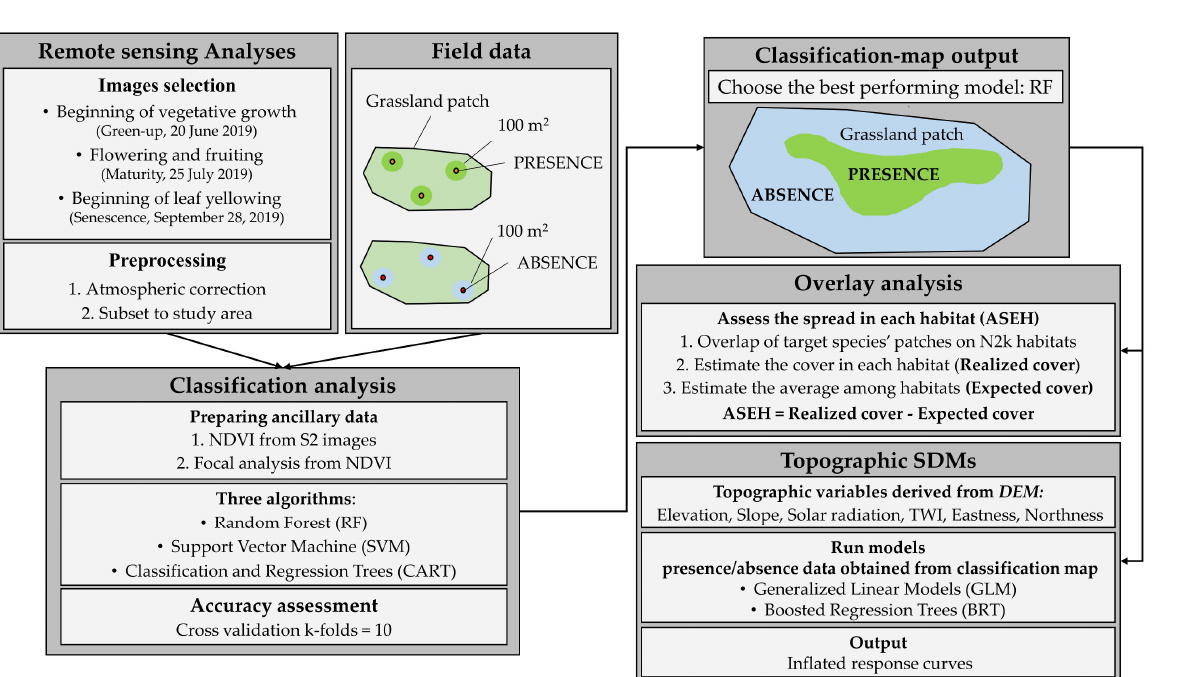
Figure 2. Summary of the workflow and methods involved in the work with focus groups.